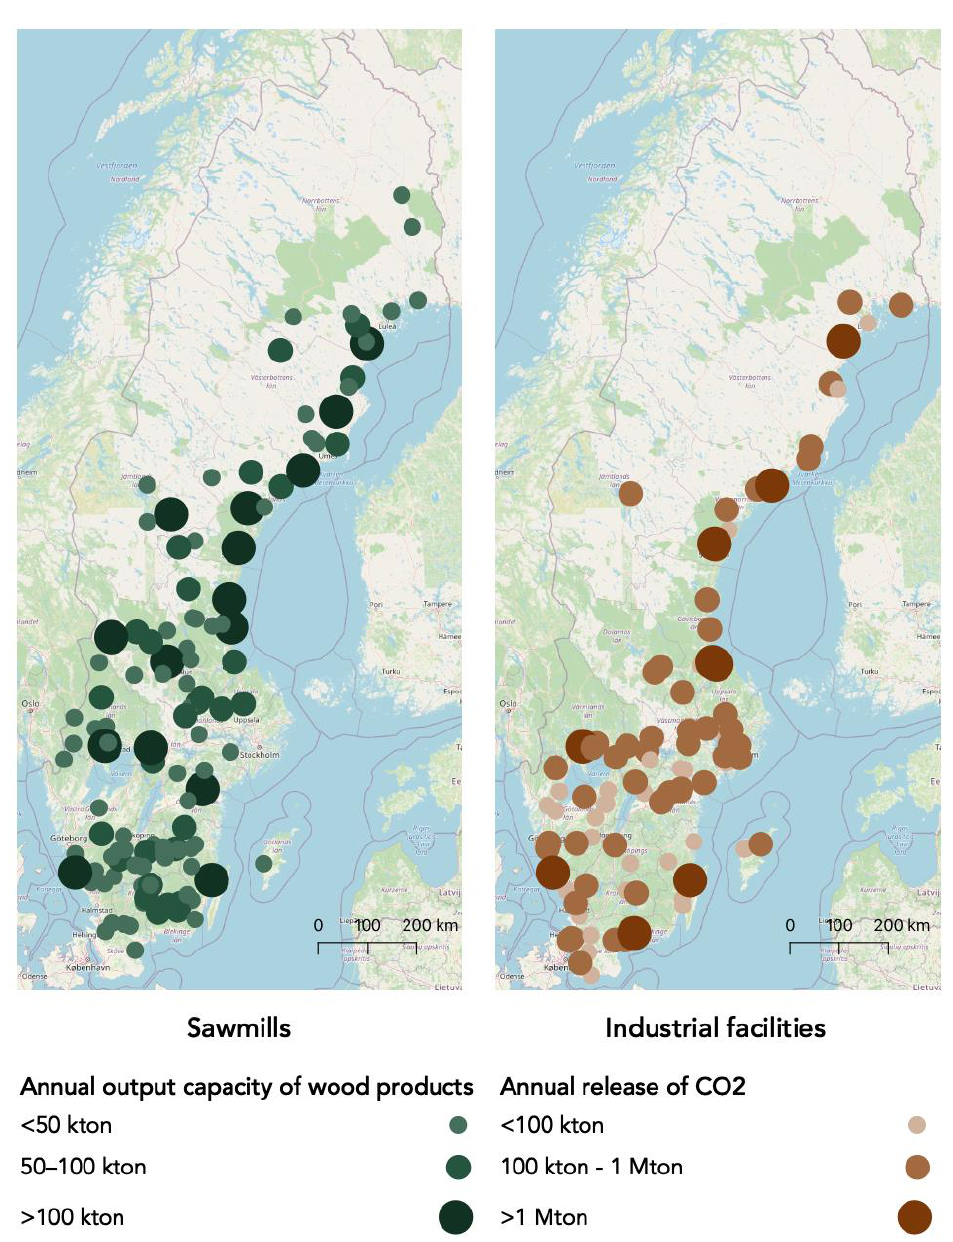
Figure 3. Locations and annual capacity of sawmills (sources of biomass) and industrial facilities (sources of CO 2 ). Base map data © OpenStreetMap contributors, available under the Open Database License, terms further described in [106].